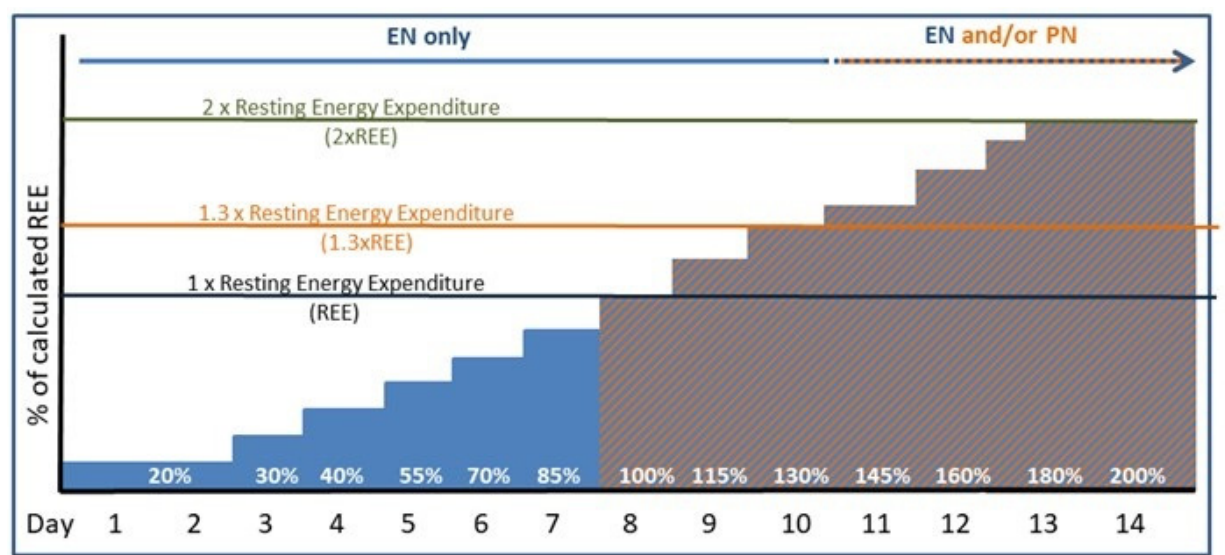
Figure 3. A stepwise approach to delivering calories with enteral and/or parenteral nutrition EN = enteral nutrition, PN = parenteral nutrition and REE = resting energy expenditure. The green line is to indicate intake (2 × REE) for neonates and infants. The purple line is to indicate the intake (1.3 × REE) for adolescents. The intake is based upon Holliday and Segar equations for maintenance fluid requirements [37].